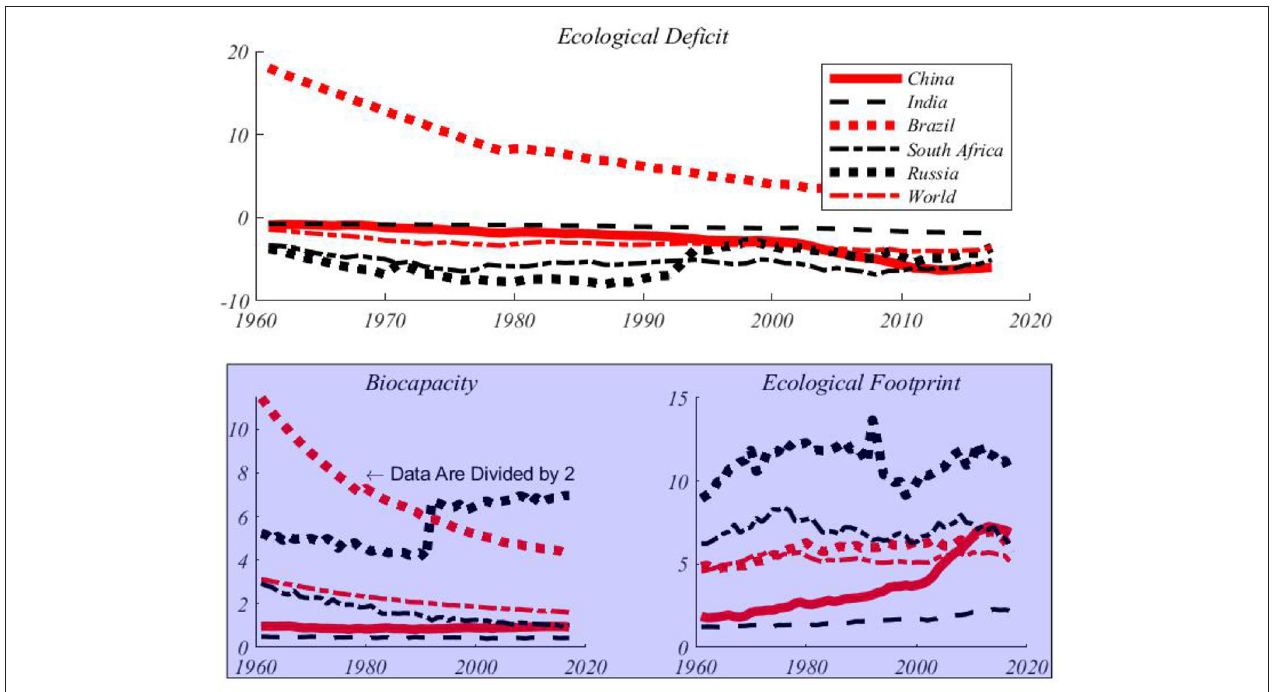
FIGURE 2 | Per capita environmental indicators for BRICS and the world (gha). Russian data before 1989 are replaced with data from the former Soviet Union. So you can see from the fifth chart that there is a jump in